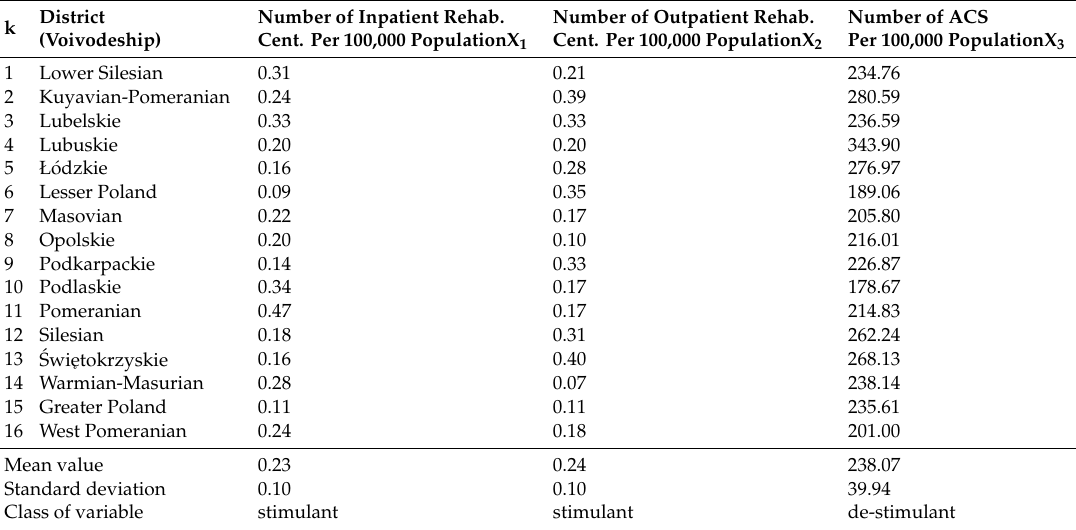
Table 2. Statistics of variables used in the research calculated per 100,000